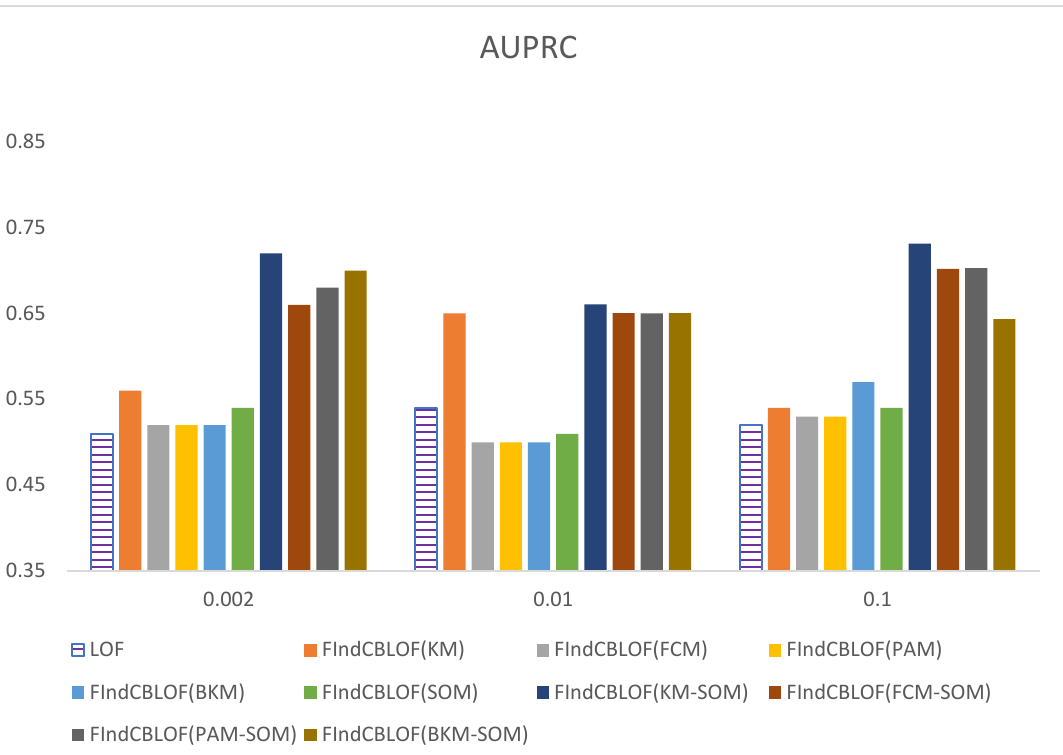
Figure 5. Detection Accuracy (European Credit Dataset).